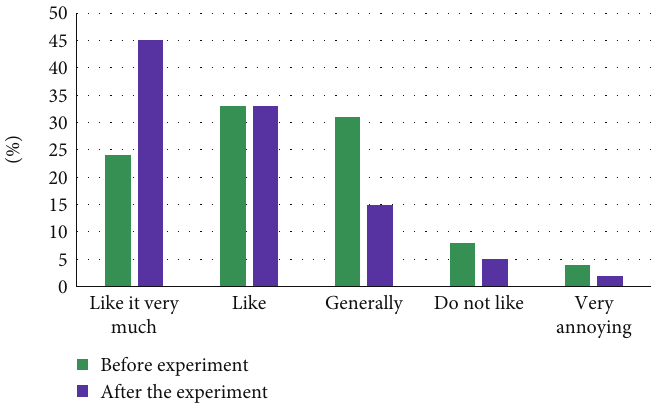
Figure 3: Proportion of options for “ Music Likeness ” among the tested students.